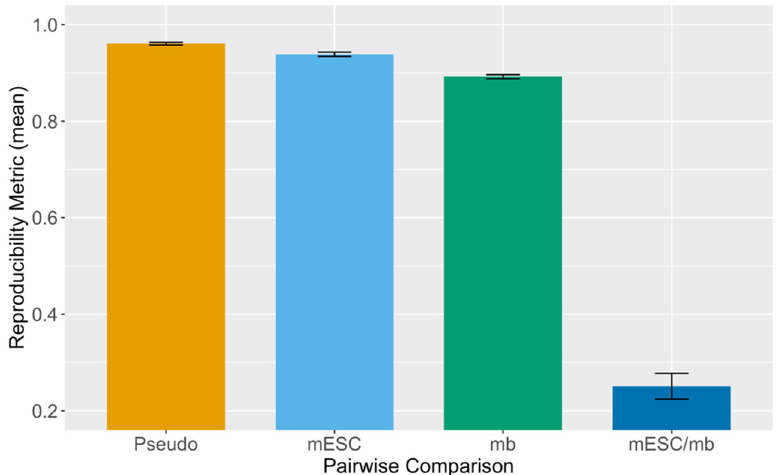
Figure 2. HPRep in mouse PLAC-Seq data. Metrics obtained applying HPRep to PLAC-Seq data from mESC and mouse brain (mb) tissues. Pseudo replicates generated from pooling two mESC samples followed by random sampling. Cross sample results represent the mean of four pairings. Results are presented as the mean value over 19 autosomal chromosomes with error bar representing ±1 standard deviation.